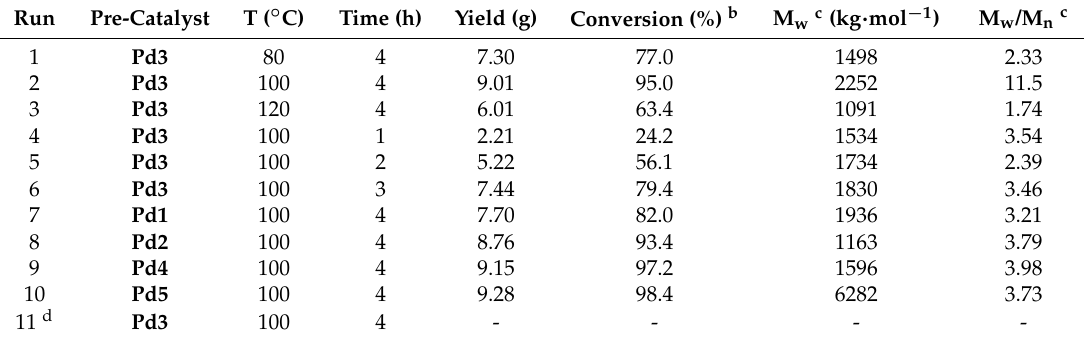
Table 1. The catalytic properties of Pd complexes for MA homopolymerization a . Table 1. T he catalytic properties of Pd complexes for MA homopolymerization a .